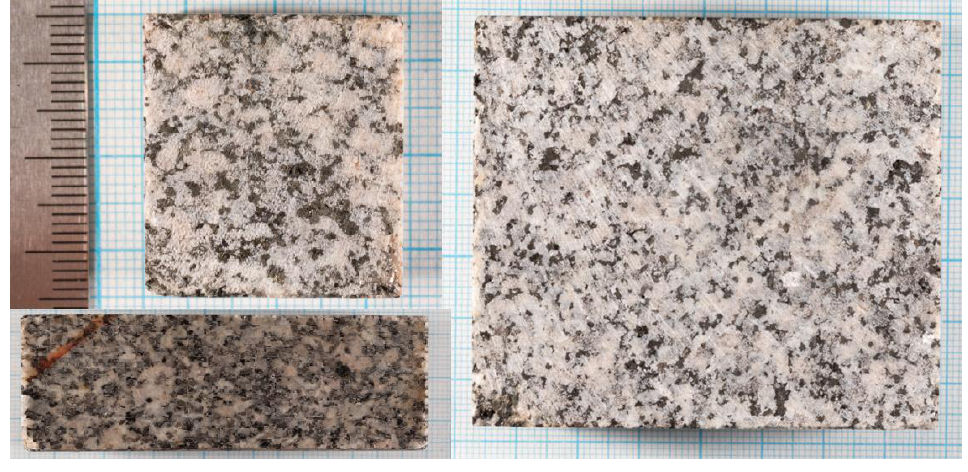
Figure 4. Experimental rock samples.